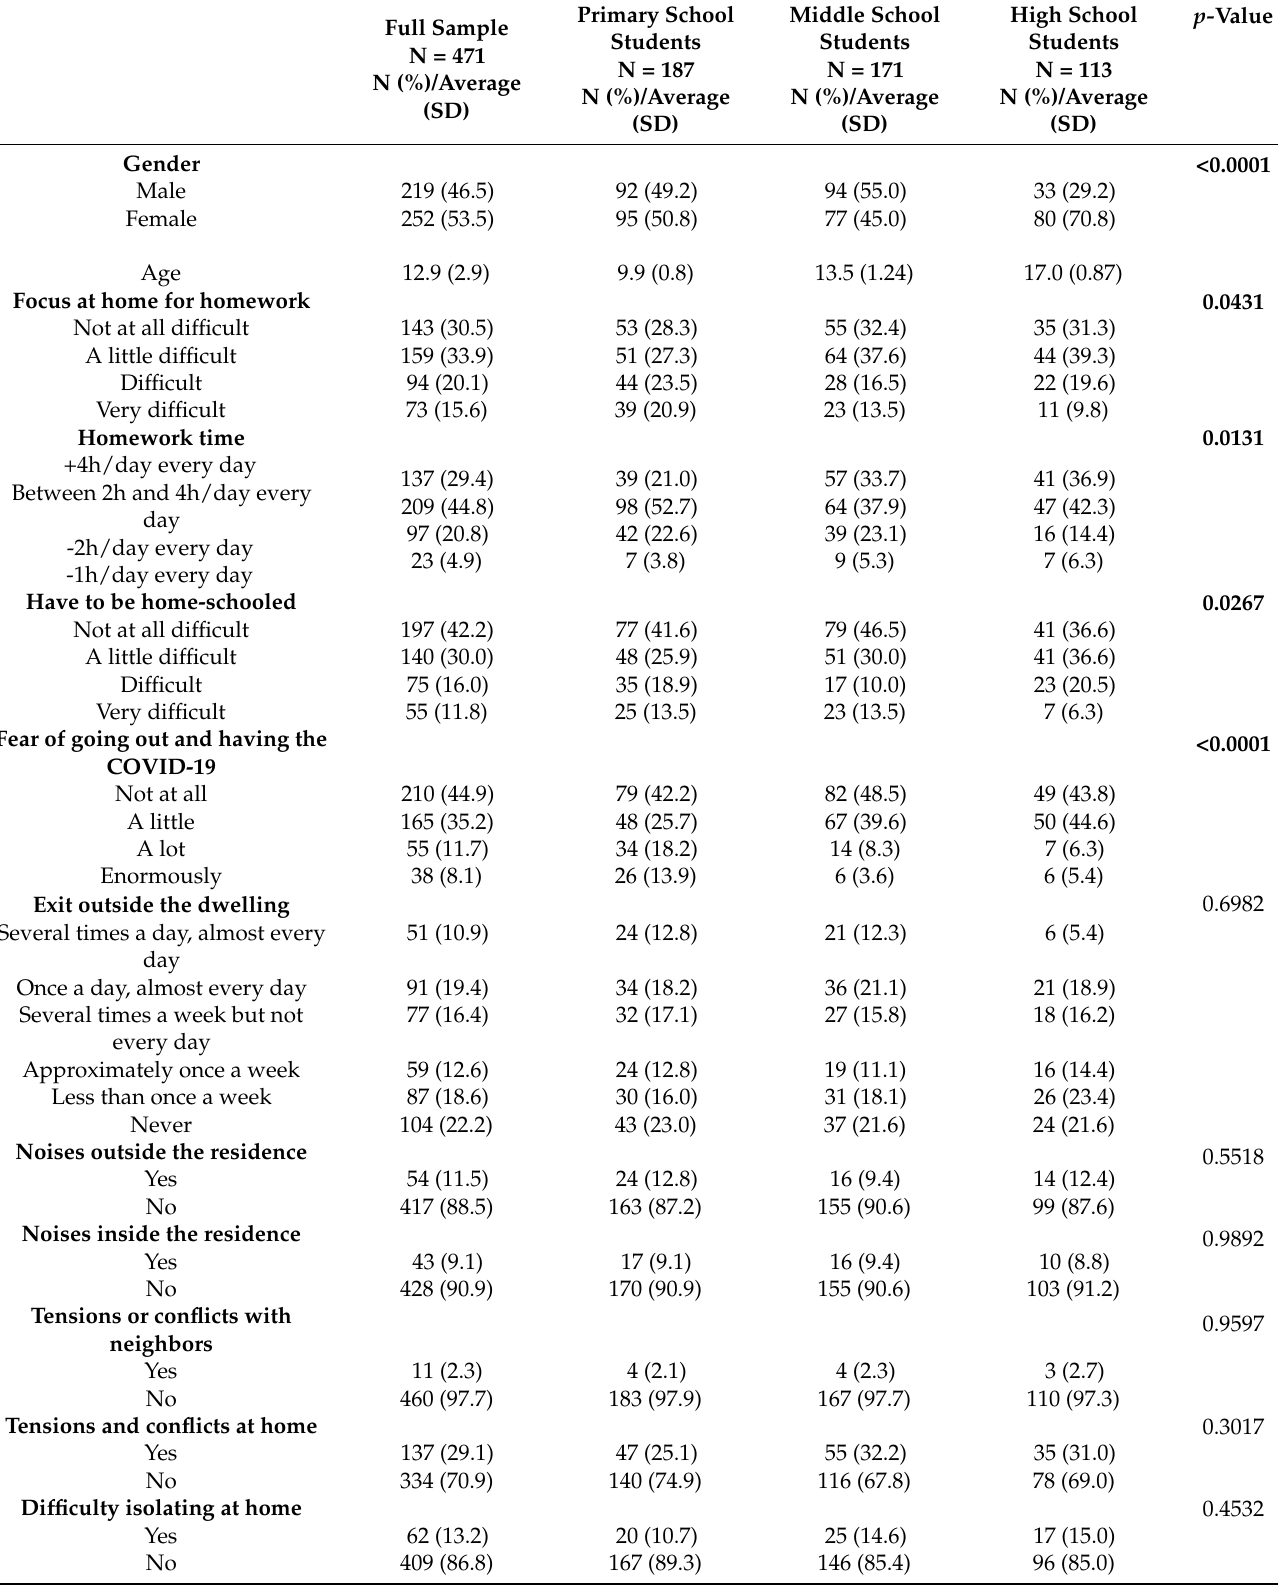
Table 2. Sociodemographic data, learning and working conditions of the children/adolescent’s